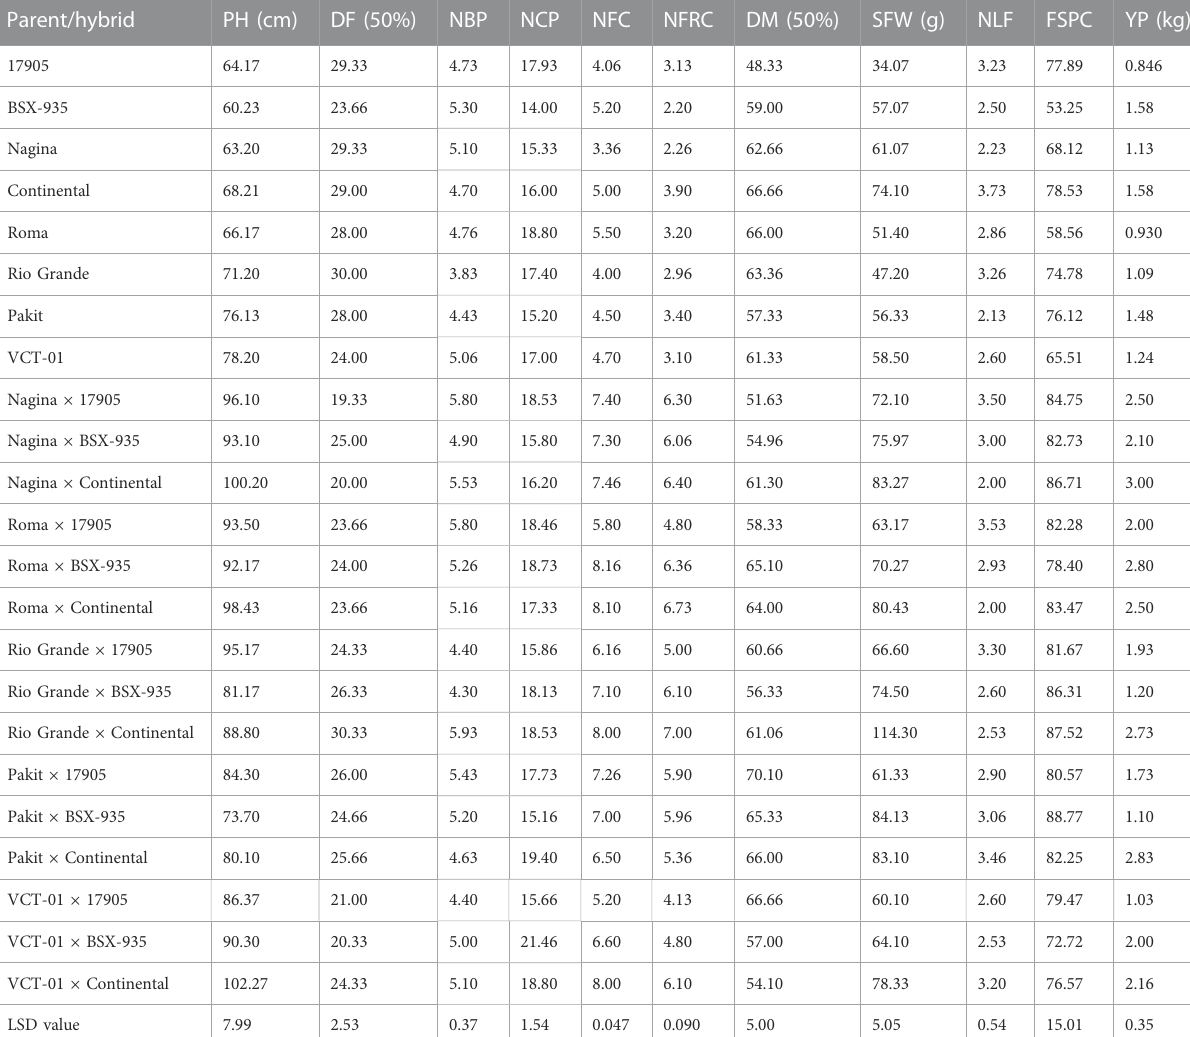
TABLE 4 Mean performance of parents and their hybrids for 11 variables.